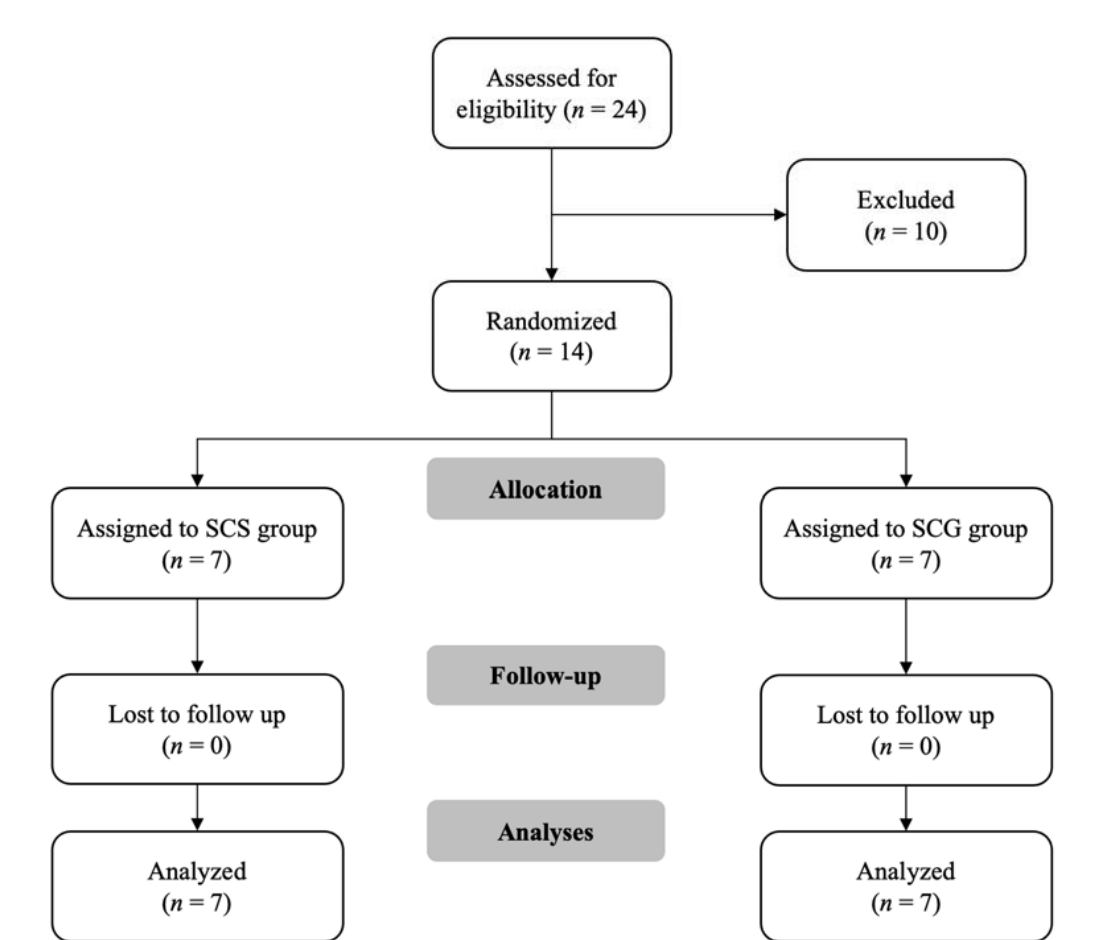
Figure 1. Consort diagram illustrating the flow of participants through the study. SCS: specific CORE stability intervention group; GCS: general CORE stability intervention group. Table 11. Participants’ characteristics.